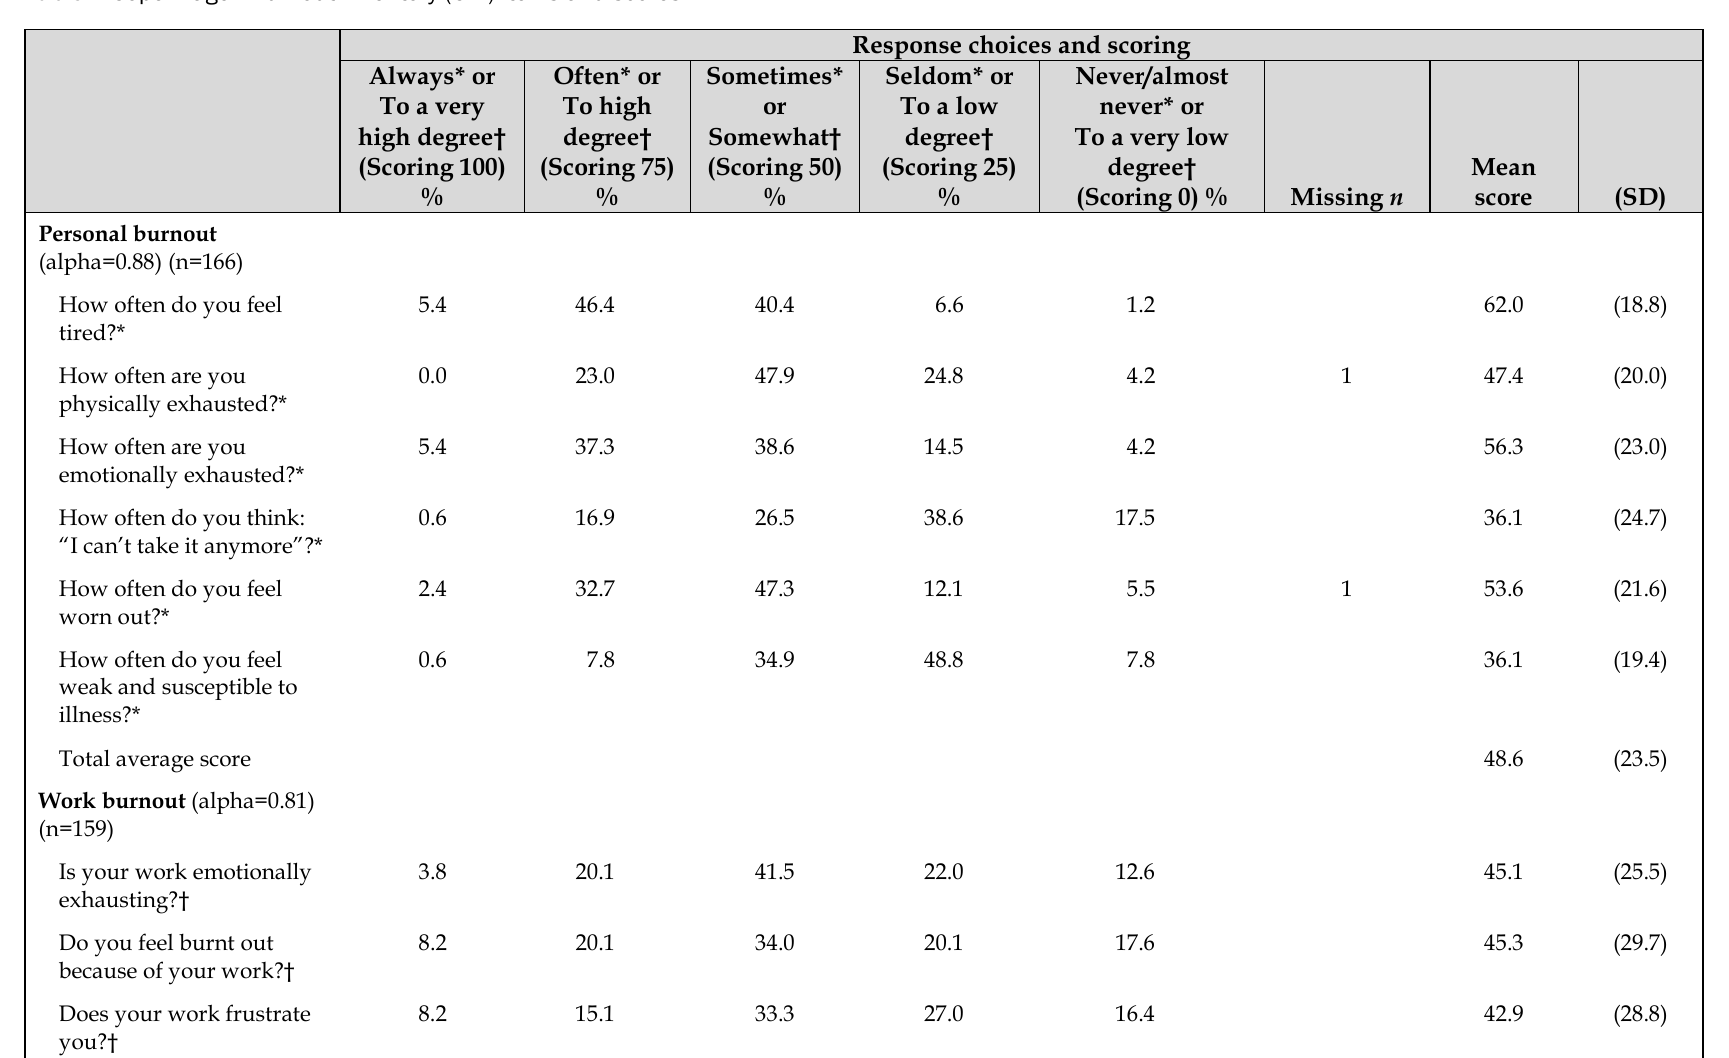
Table 1 Copenhagen Burnout Inventory (CBI) items and